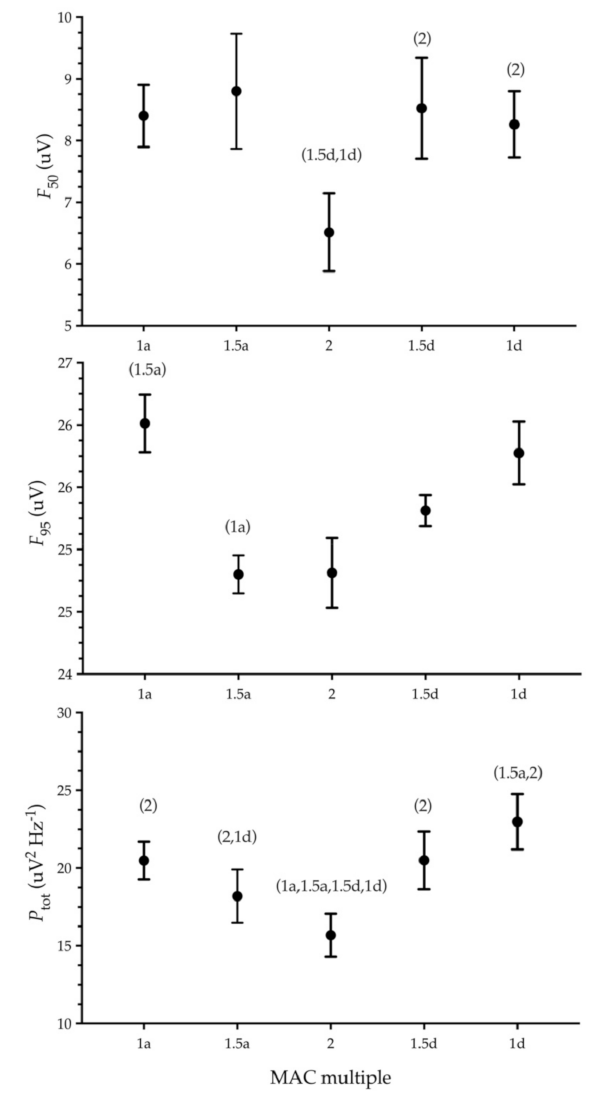
Figure 1. The mean ± standard error ( n = 8 birds) of the F 50 , F 95 and P tot at the ascending ( a ) and descending ( d ) MAC multiples. Above, each mean value the MAC multiples that were significantly different are listed in parentheses ( p <